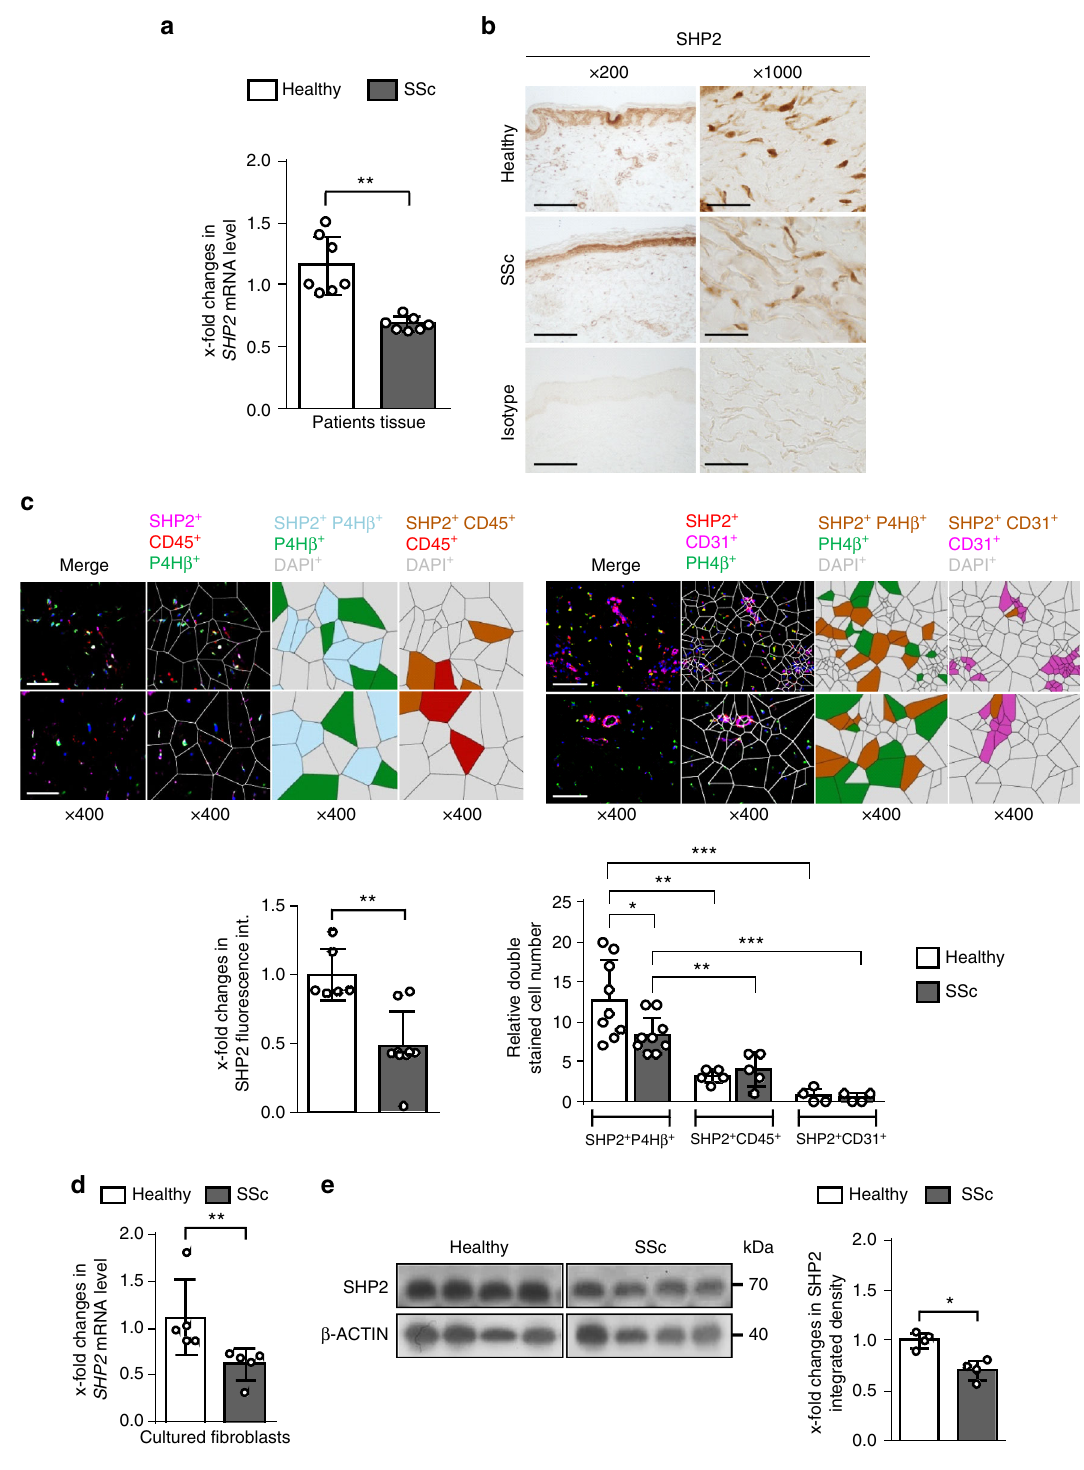
Fig. 1 Decreased expression of SHP2 in SSc. a The mRNA levels of SHP2 are signi fi cantly reduced in SSc skin as compared to healthy skin ( n = 7). b Immunohistochemistry of SHP2 in SSc skin and matched healthy controls. Representative images are shown at 200- and 1000-fold magni fi cation. c Immuno fl uorescence staining of SHP2 with co-staining for the fi broblast marker P4H β , the endothelial cell marker CD31 and the leukocyte marker CD45, and DAPI. SSc fi broblasts demonstrated a reduced staining for SHP2 compared to healthy control. Representative images are shown at 400-fold magni fi cation. Immuno fl uorescence pictures were processed to generate Voronoi tessellated pictures amenable to computational simulation. Quanti fi cation of SHP2 staining intensity ( n = 5) and of SHP2-positive cells ( n = 5). d , e The mRNA ( n = 5) ( d ) and protein level ( n = 4) ( e ) of SHP2 are decreased in cultured SSc fi broblasts. Horizontal scale bar, for all images, 500 μ m. All data are presented as median± s.e.m. The p values are expressed as follows: 0.05 > p > 0.01*; 0.01 > p > 0.001**; p < 0.001***. Signi fi cance was determined by Mann – Whitney test. SSc: systemic sclerosis, Healthy: healthy individual, int.: